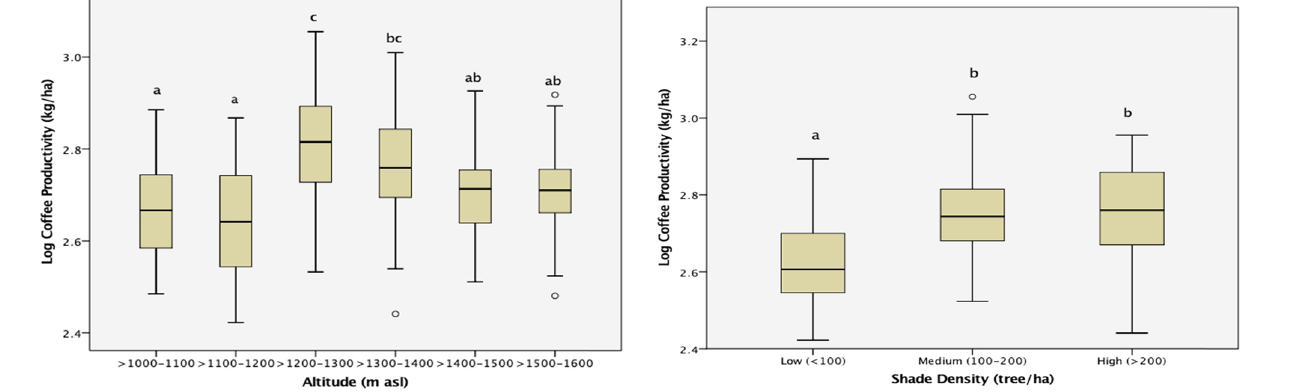
Figure 2: The e ff ect of altitudes on log co ff ee productivity; general linear model ( P < 0.000 ) ; means followed by the same letter did not di ff er ( LSD P < 0.05 ) .